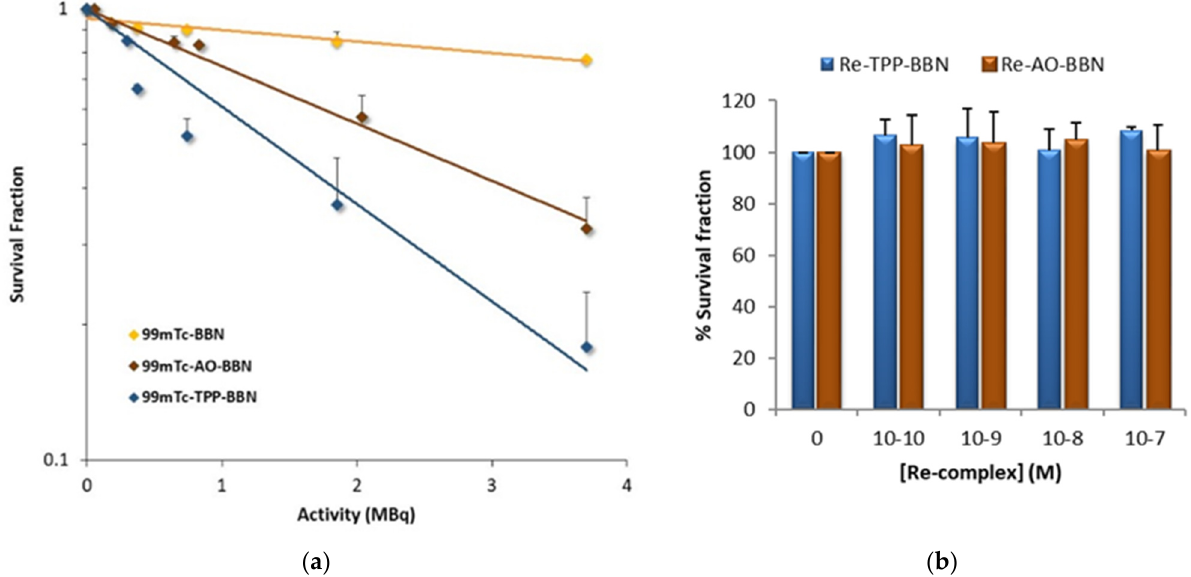
Figure 6. Survival fraction from clonogenic assay experiments. (a) PC3 cells were incubated with 0– 3.7 MBq of HPLC-purified 99m Tc-BBN, 99m Tc-AO-BBN and 99m Tc-TPP-BBN for 24 h at 37 °C. The lethal dose (LD 50 ) was >5, 2.92 and 1.39 MBq for 99m Tc-BBN, 99m Tc-AO-BBN and 99m Tc-TPP-BBN , respectively. (b) PC3 cells were incubated with Re-AO-BBN and Re-TPP-BBN complexes (0, 10 − 7 , 10 − 8 , 10 − 9 and 10 − 10 M) for 24 h at 37 °C. The data correspond to the mean ± SEM of 3 replicates.